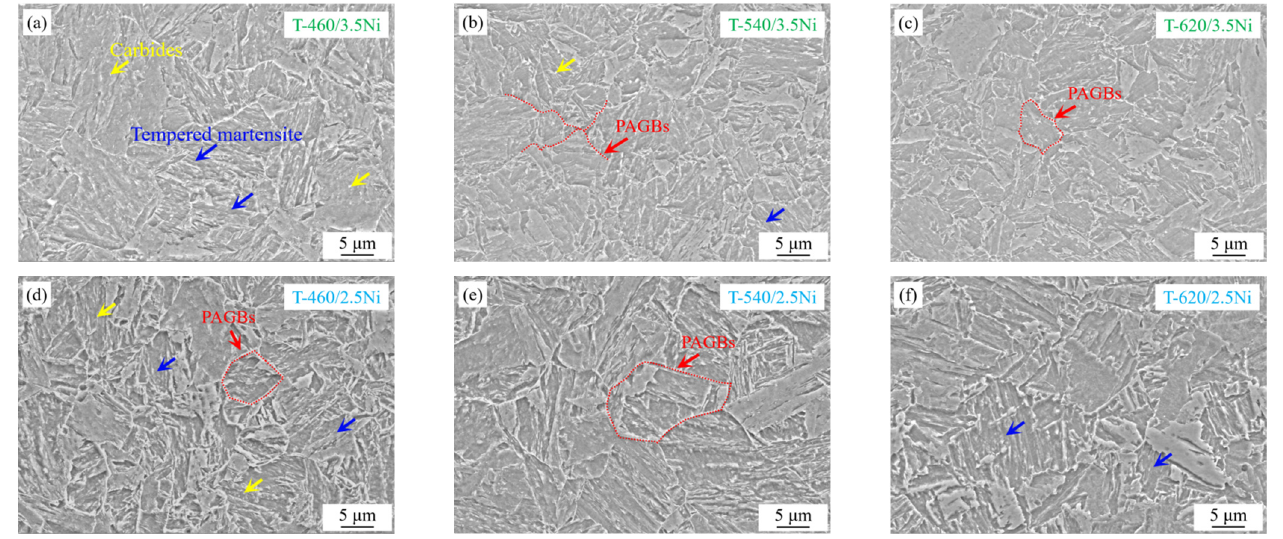
Figure 3. Selected SEM morphologies of both steels after tempering at ( a , d ) 460, ( b , e ) 540 and ( c , f ) 620 °C.